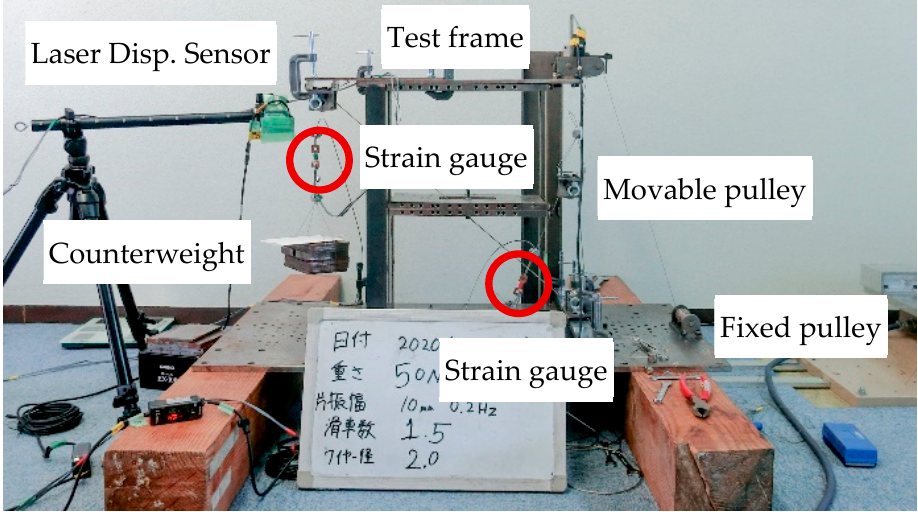
Figure 6. Test setup for characterizing friction behavior under sinusoidal wave excitation. Table 1. Information on the friction test.